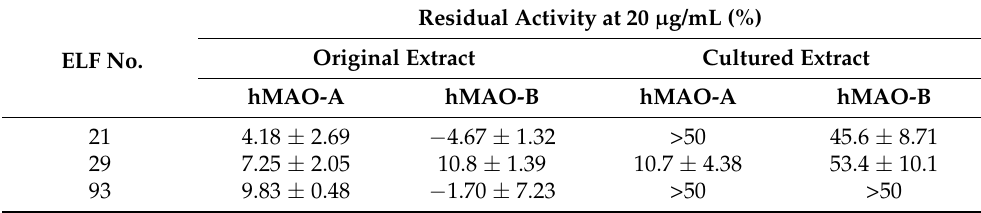
Table 2. Inhibitory activities of the original and cultured extracts of ELF candidates against hMAO-A and hMAO-B.